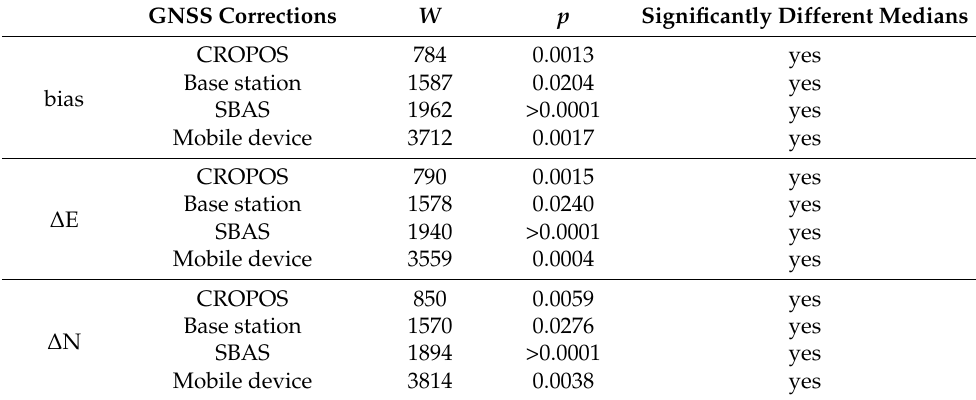
Table 4. Wilcoxon test results for GNSS positioning